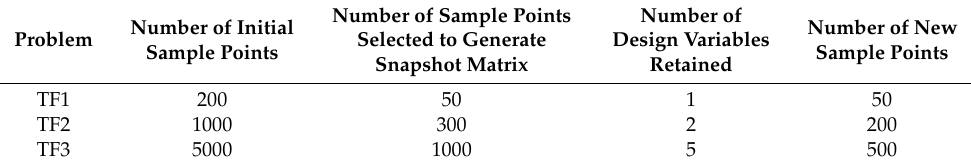
Table 2. Parameter settings of M ‐ POD (POD coupling with adaptive sampling method)